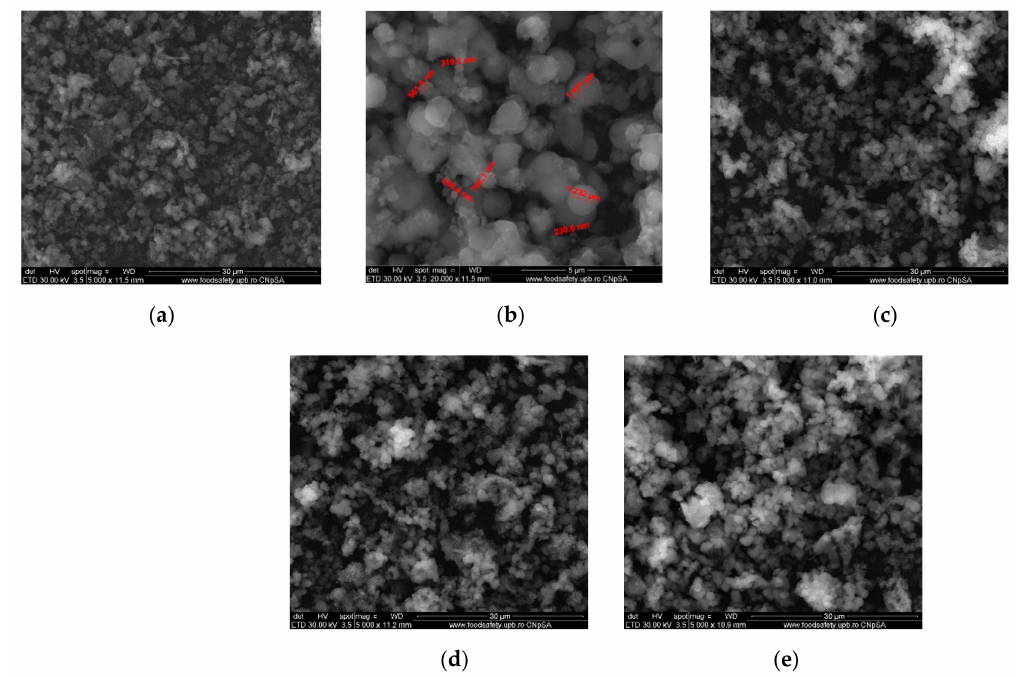
Figure 1. SEM images for initial MCM-41 material ( a ), MCM-41 with particle size details ( b ), MCM-